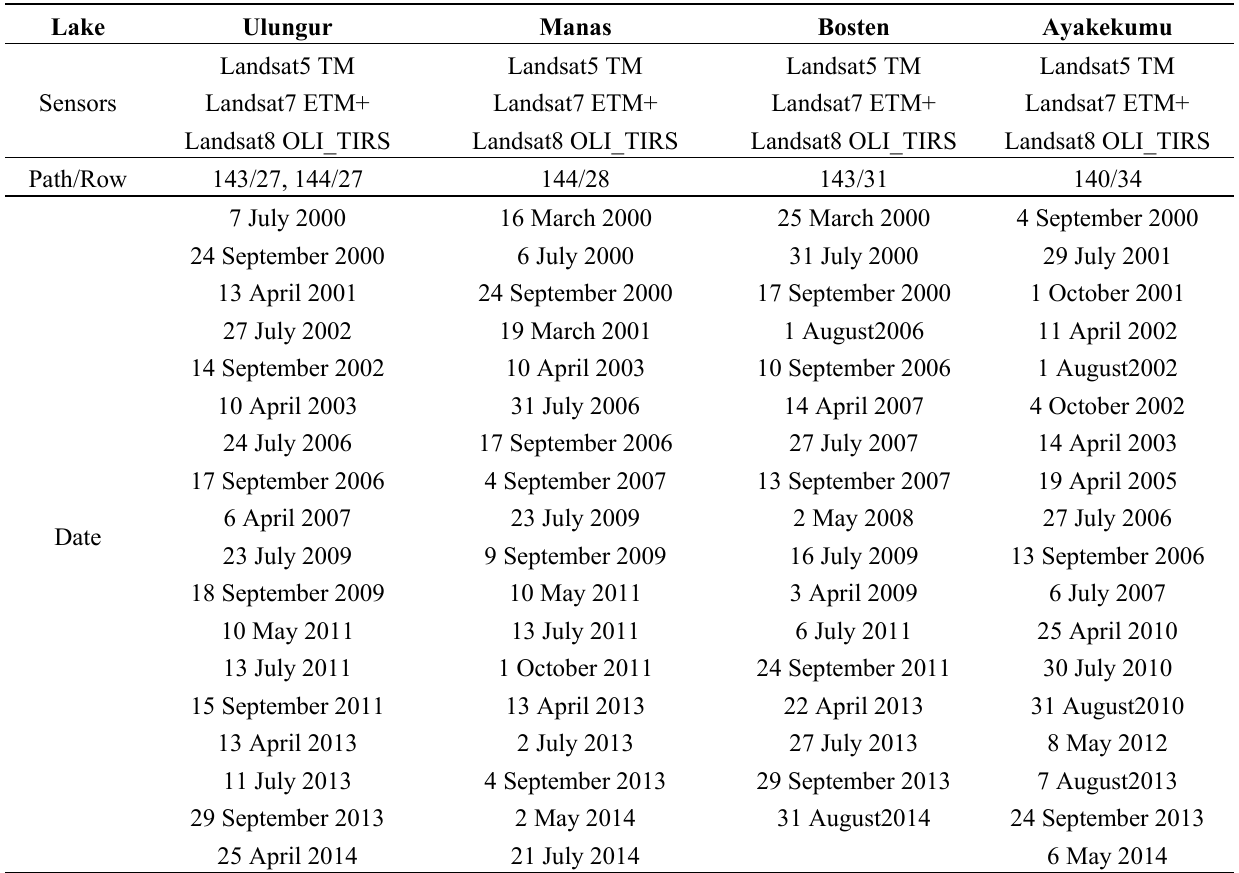
Table 2. Landsat data used in our